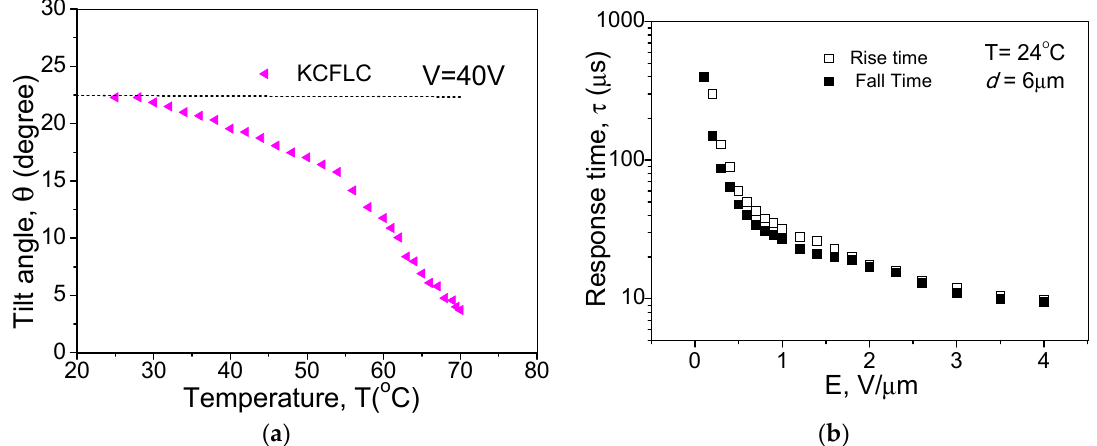
Figure 6. ( a ) Temperature-dependent molecular tilt angle ( θ ) and ( b ) the electric field-dependent response time ( τ ) for the KCFLC 10R sample in a planar aligned cell with cell thickness of 6 μ m. The measurement was performed at 24 °C.